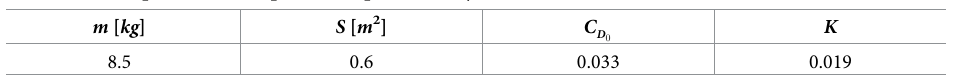
Table 3. Vehicle parameters adopted in the present analysis